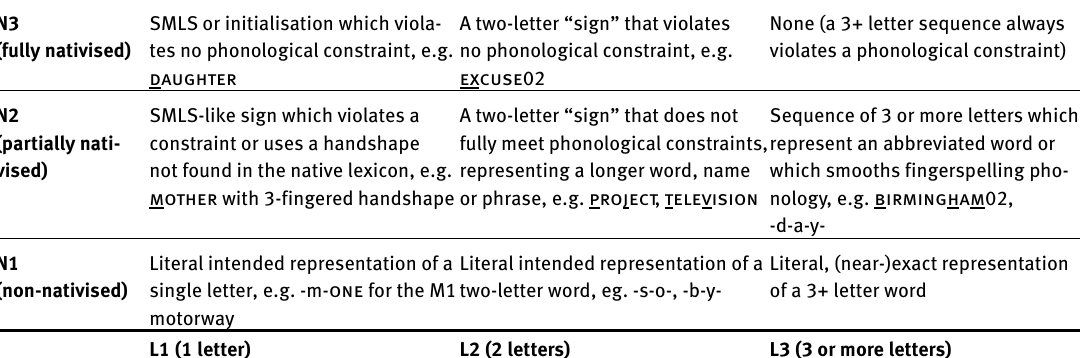
Table 2: Description of the typical “type” of token described by each L-N- annotation